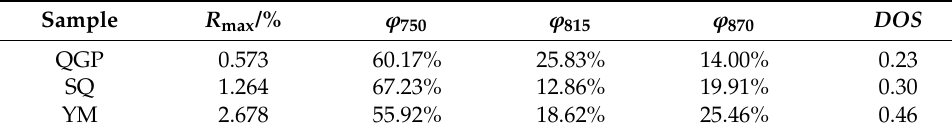
Figure 2. Fitting results and occurrence content of Aromatic hydrocarbon in coal samples. Table 1. DOS